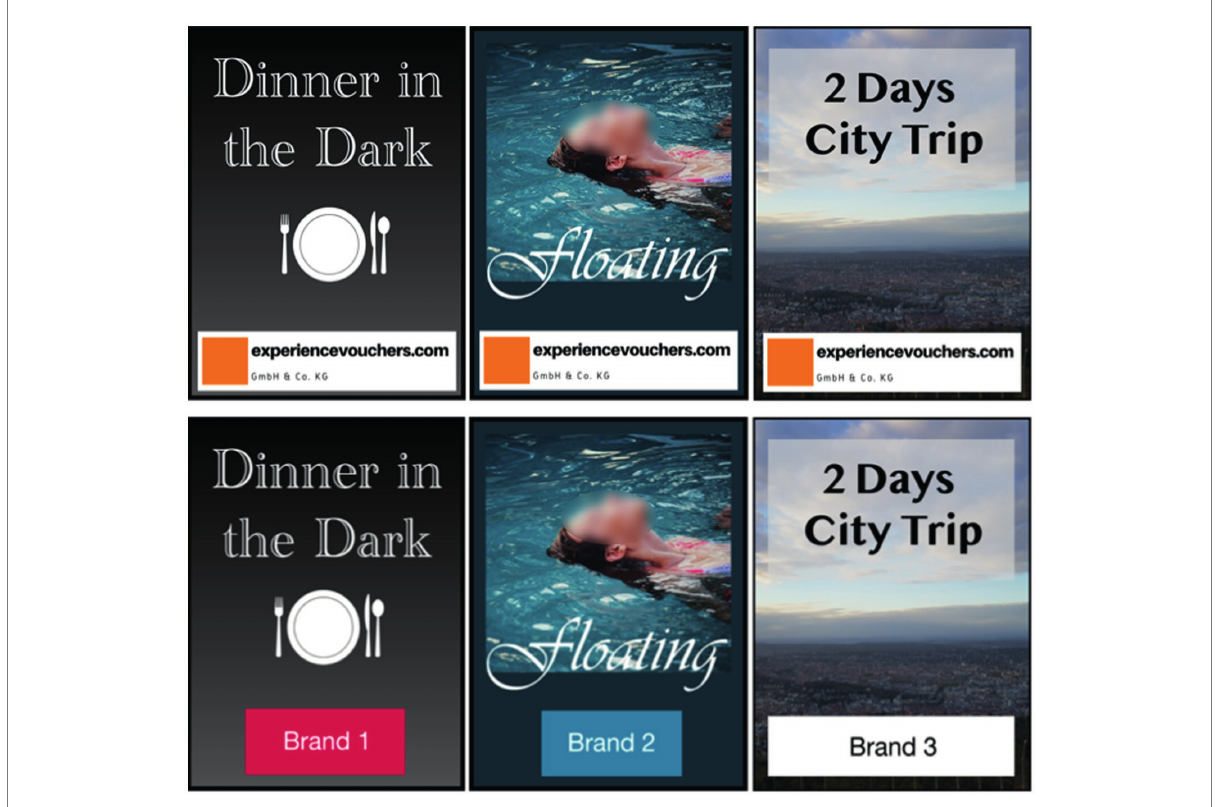
FIGURE 4 Recommended experience vouchers for conditions with external manipulative intent of the supporting organization (top) and for conditions without (bottom). Adapted/reproduced from